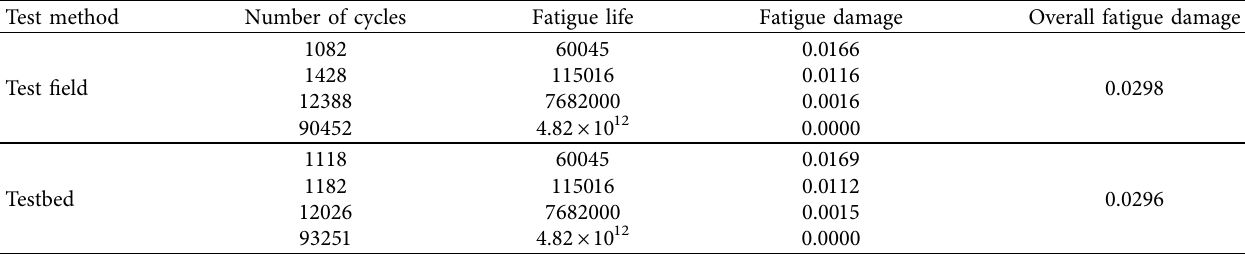
Table 1: Comparison of fatigue damage data under random loading.